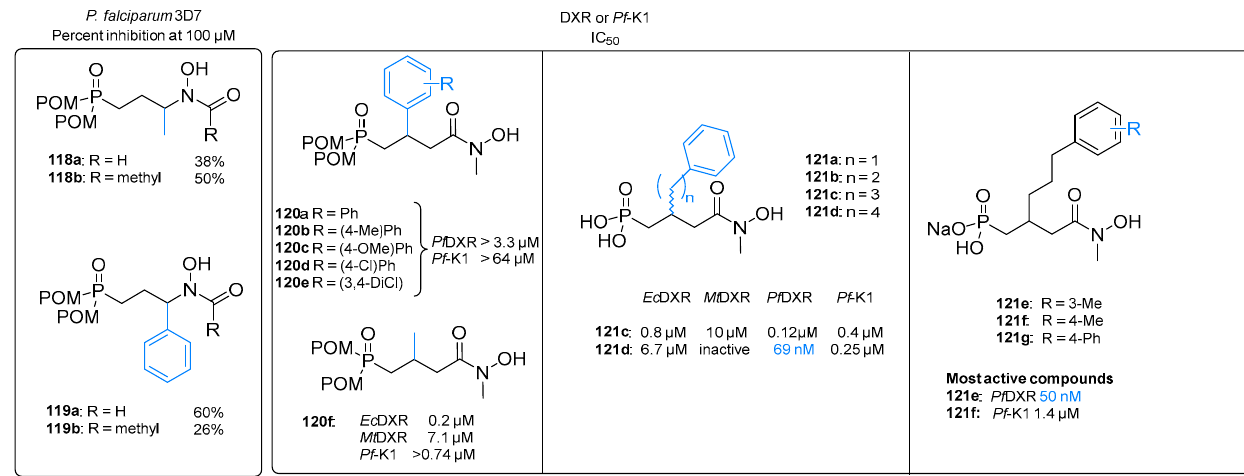
Figure 27 . Antiplasmodial activity of β - and γ -substituted analogs ( 118 – 121